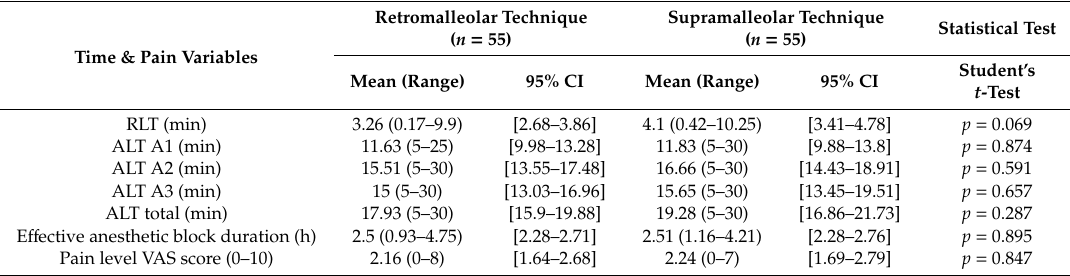
Table 3. Comparisons of anesthesia times and levels of pain registered during the two anesthetic